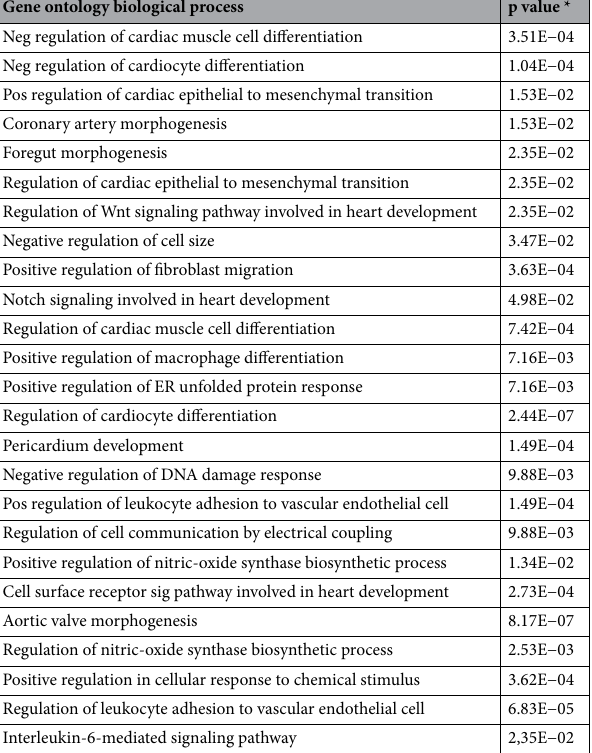
Table 3. Top 25 over-represented functional classes for miRNA targets. *Bonferroni adjusted p